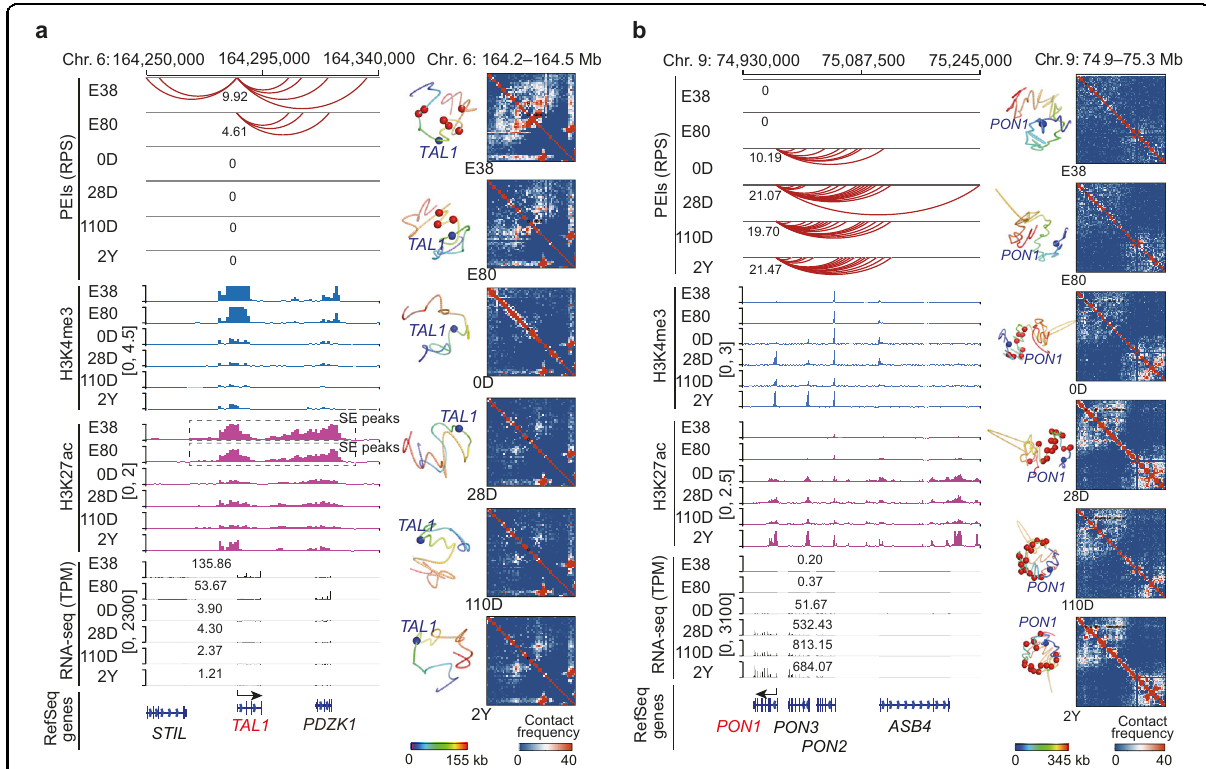
Fig. 6 Examples of PEI rewiring related to transition of liver functions during development. a TAL1 and b PON1 respectively participate in hematopoiesis and drug metabolism. Left: schematics of PEIs, H3K4me3, and H3K27ac signals, and transcription. Right: 3D structural models and Hi-C contact maps of the corresponding genomic regions. Gene promoters (blue spheres) and enhancers (red spheres) are